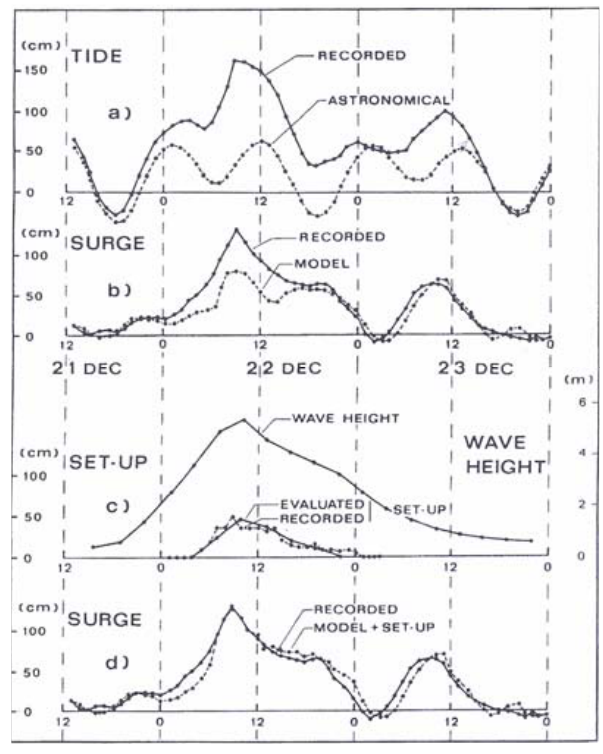
Fig. 15. (a) recorded water level and astronomical tide at Venice during the 22 December 1979 event. (b) recorded storm surge level (difference of the graphs in (a) and model prediction. (c) wave height at the tower, evaluated and recorded wave set-up at the har- bour entrance. (d) recorded storm surge level (same as (b) ) and cor- responding surge+set-up model results (after Cavaleri et al.,